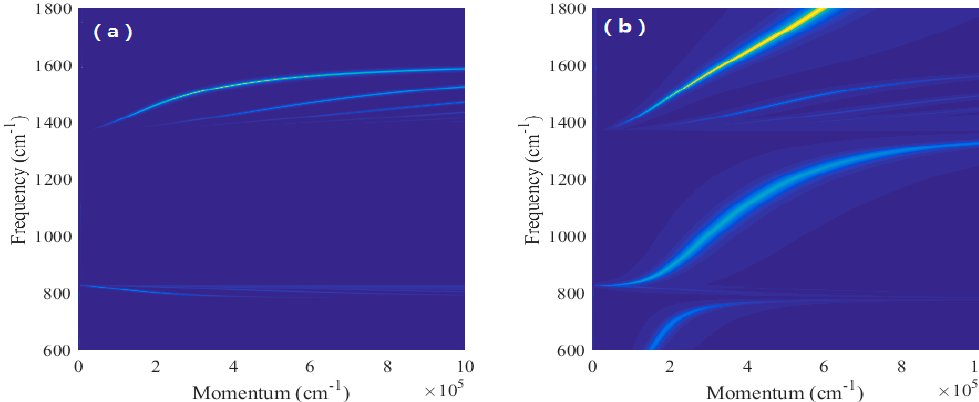
Figure 8. The transmission properties of ( a ) air/h-BN/Ag/SiO 2 heterostructure and ( b ) air/graphene/h-BN/Ag/SiO 2 heterostructure. Here, the thickness of the h-BN slab and silver slab are 50 nm and 10 nm, respectively. The Fermi energy of graphene is 0.5 eV.